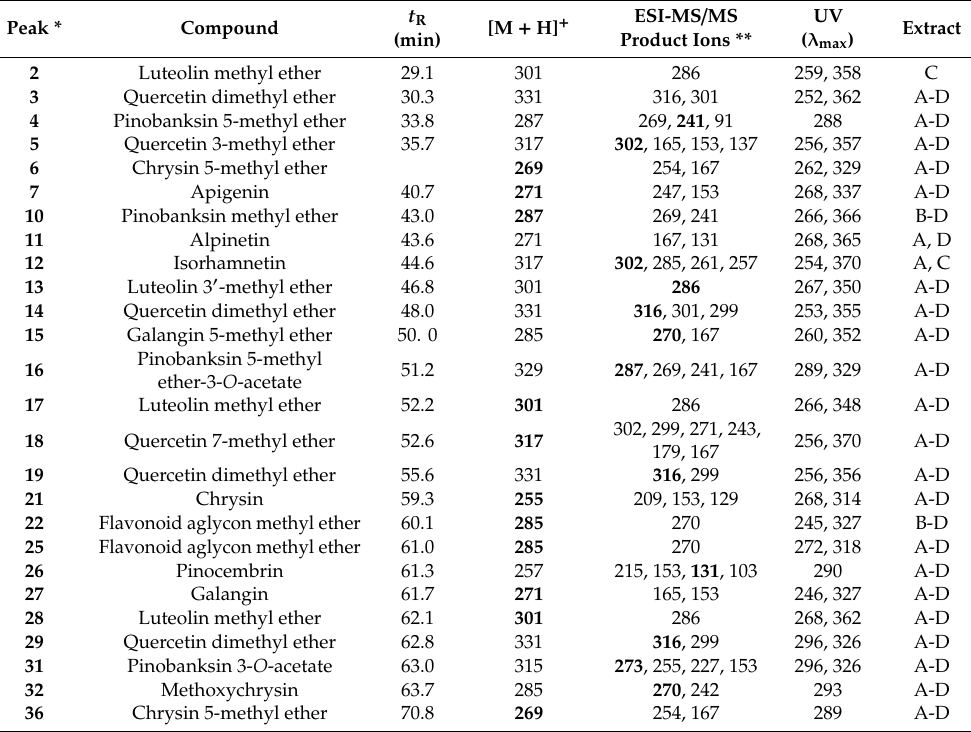
Table 2. Chromatographic ( t R = retention time), UV, and positive ion mode ESI-MS / MS data of the constituents identified in Italian propolis extracts: A, Pietradefusi; B, Melito Irpino; C, Melizzano; D, Vallata.